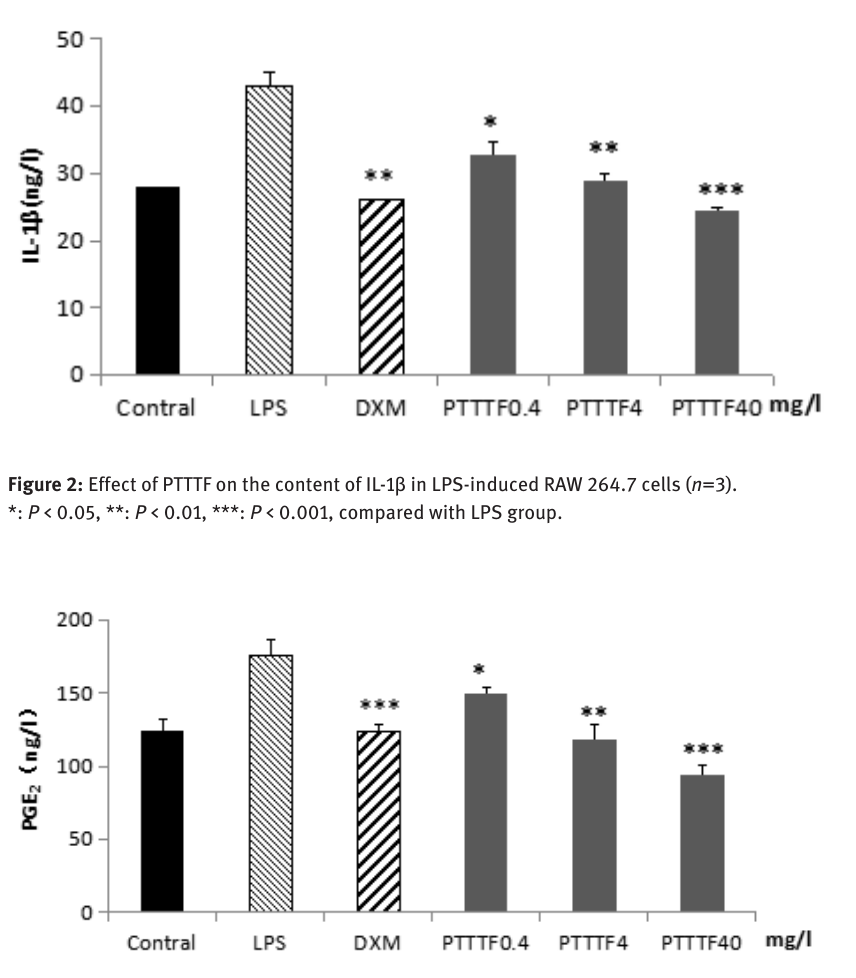
Figure 3: Effect of PTTTF on the content of PGE *: P < 0.05, **: P < 0.01, ***: P < 0.001, compared with LPS